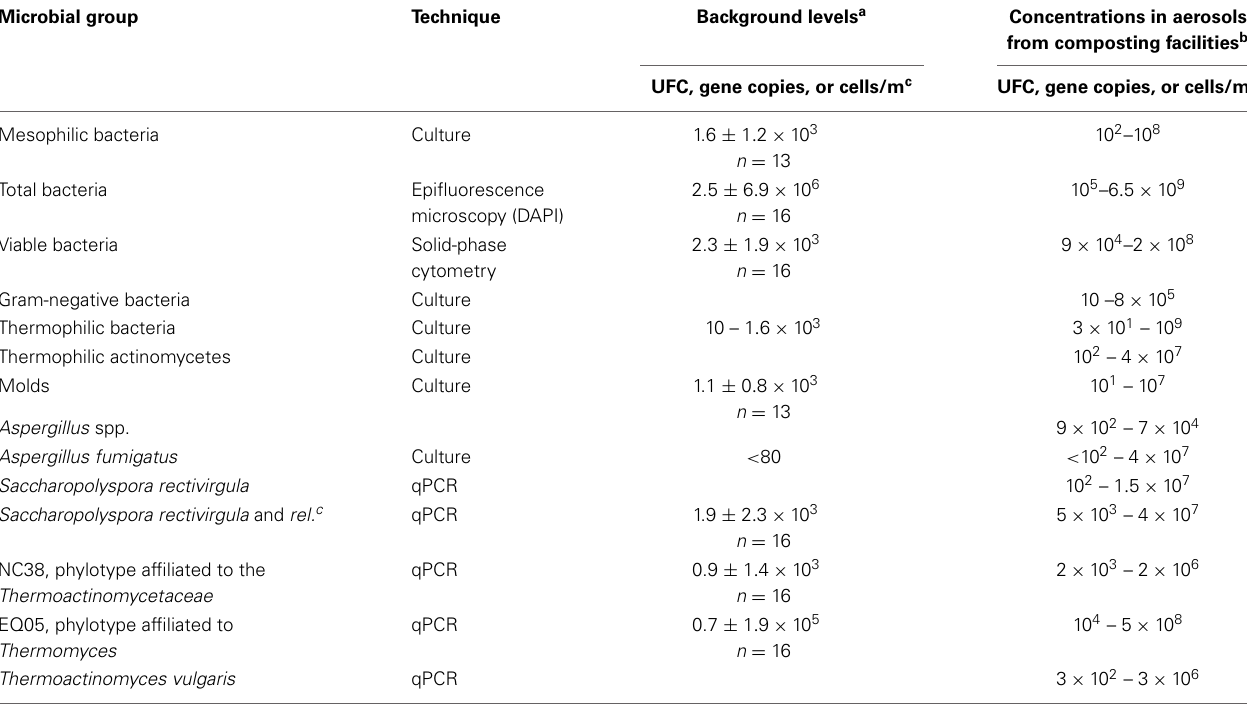
Table 3 | Microbial groups used to monitor bioaerosols from composting facilities from O’Gorman and Fuller (2008), Schlosser et al. (2009), Persoons et al. (2010), Pankhurst et al. (2011), ADEME (2012), Le Goff et al. (2012), Schäfer et al. (2013), and Betelli et al. (2013). Microbial